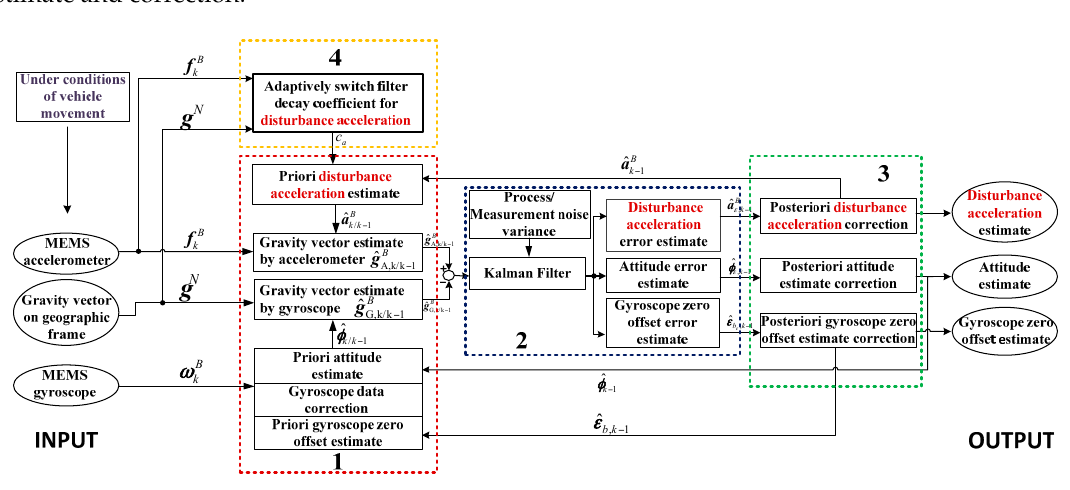
Figure 1. Framework of attitude estimation based on the disturbance acceleration adaptive estimate and correction.